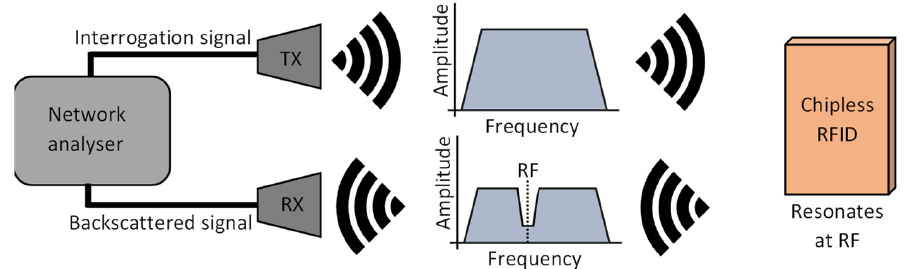
Figure 2. A basic CMPA.